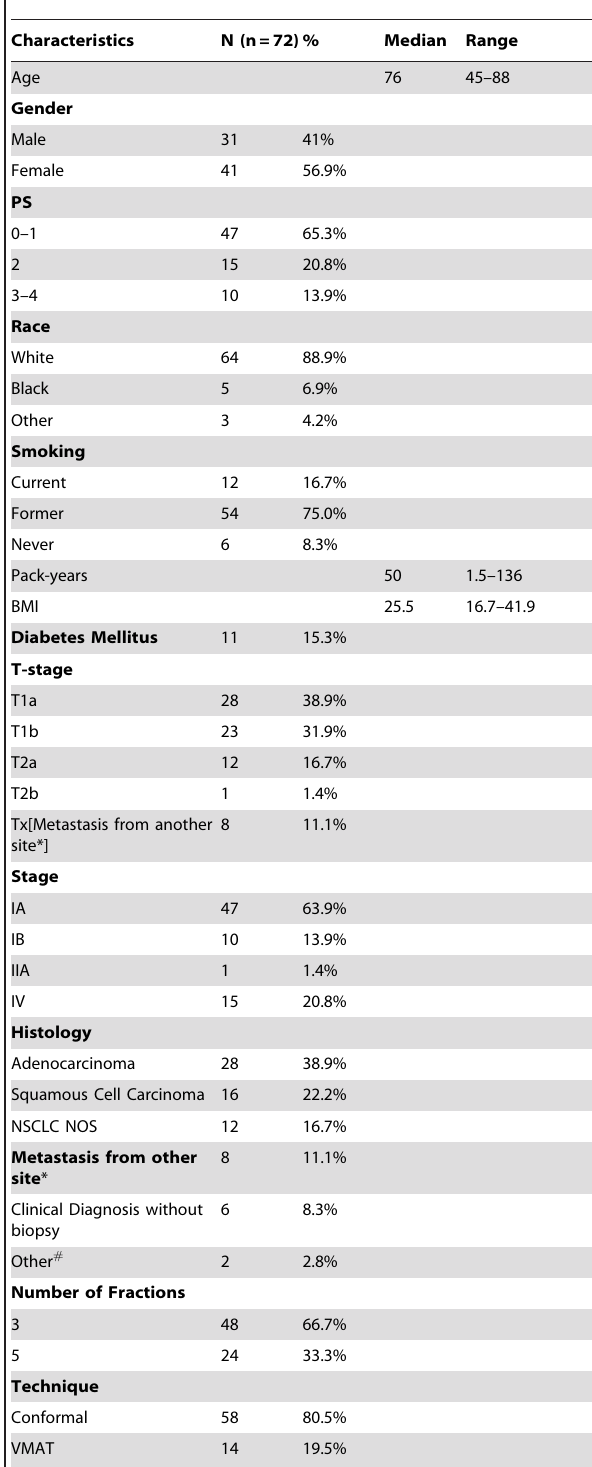
Table 2. Patient and Treatment Characteristics for 72 peripheral lung SBRT treatment plans.